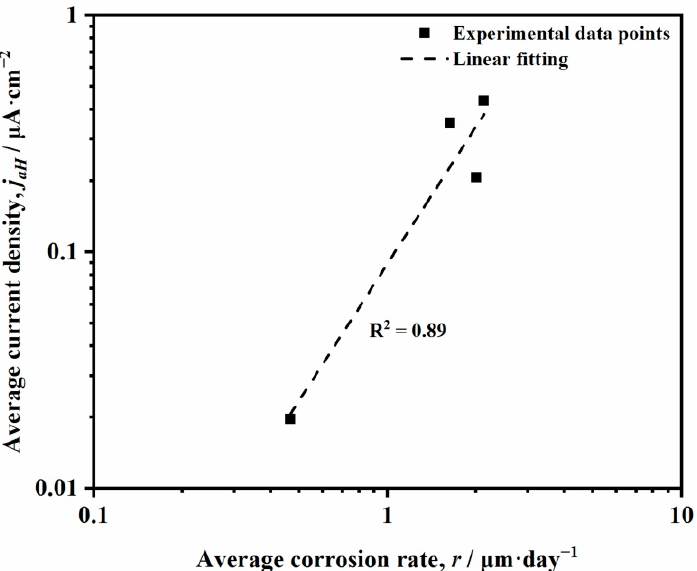
Figure 13. Relationship between the time-averaged hydrogen permeation current density ( j aH ) and the time-averaged corrosion thickness loss rate ( r ) of the hydrogen permeation sensors in the entire duration of the outdoor hydrogen permeation